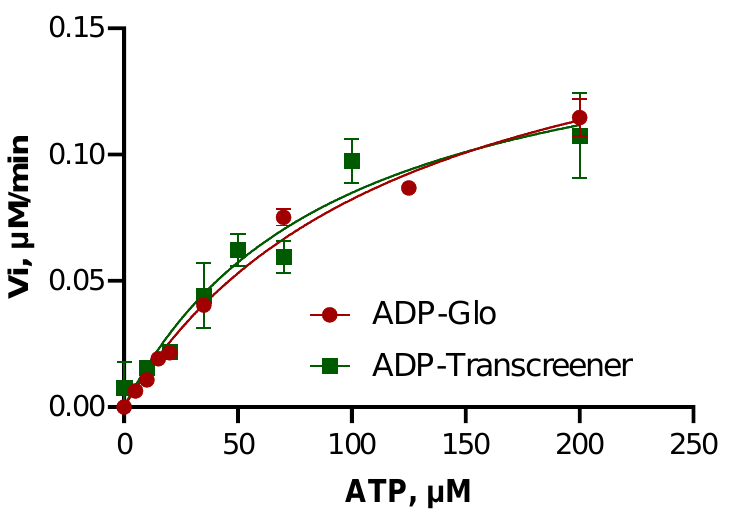
Figure 4. Michaelis–Menten plots of BceF kinase domain. Michaelis–Menten plots of the isolated BceF kinase domain measured by Tran- screener ® and ADP-Glo TM assays for the phosphorylation of the 733 AAVHE Y LSA 741 pep- tide.